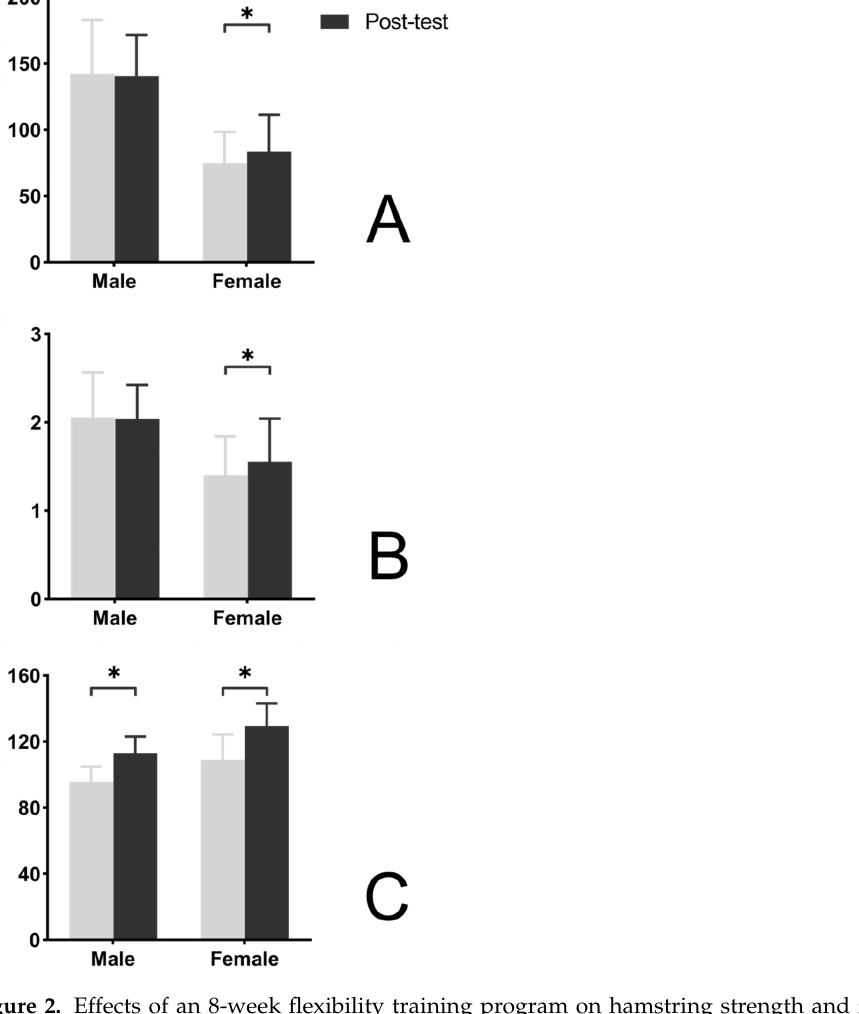
Figure 2. Effects of an 8-week flexibility training program on hamstring strength and flexibility. ( A ) Training effect on peak torque. ( B ) Training effect on relative peak torque. ( C ) Training effect on hip flexion angle. * Significant training effects.